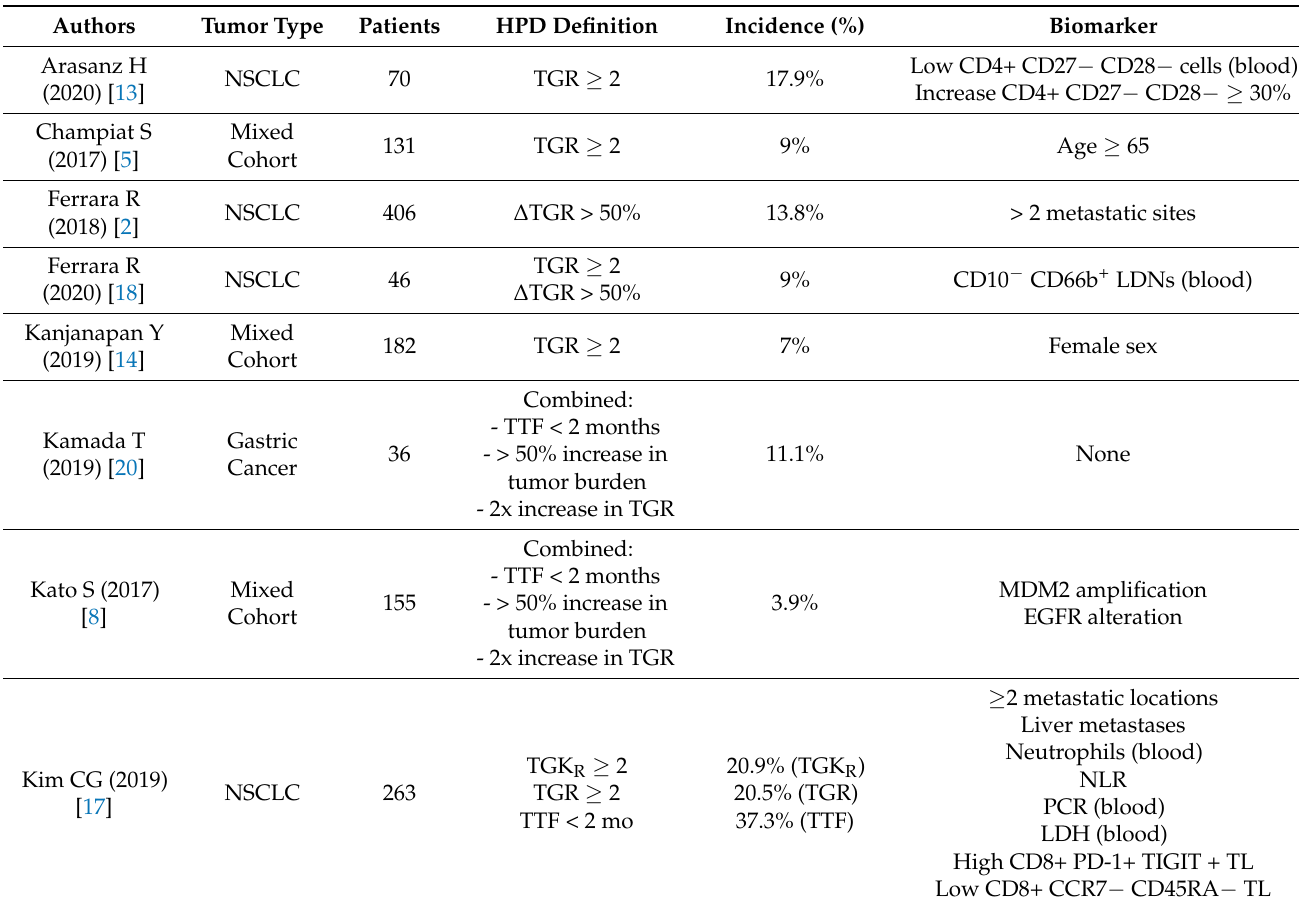
Table 1. Summary of the most relevant works studying hyperprogressive disease. HNSCC: head and neck squamous cell cancer; LDH: lactate dehydrogenase; LDNs: low-density neutrophils; NLR: neutrophils-to-lymphocyte ratio; NSCLC: non-small cell lung cancer; PCR: protein C-reactive; PD: progressive disease; PS: performance status; SNP: single-nucleotide polymorphism; TGK: tumor growth kinetics; TGK R : tumor growth kinetics ratio; TGR: tumor growth ratio; TL: T lympho- cyte; TTF: time to